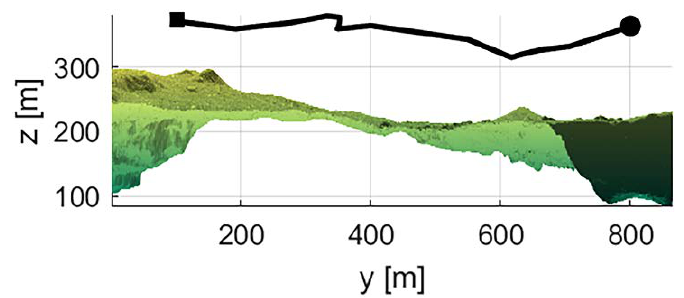
Figure 11. Convergence graph of the fitness function of the three algorithms.